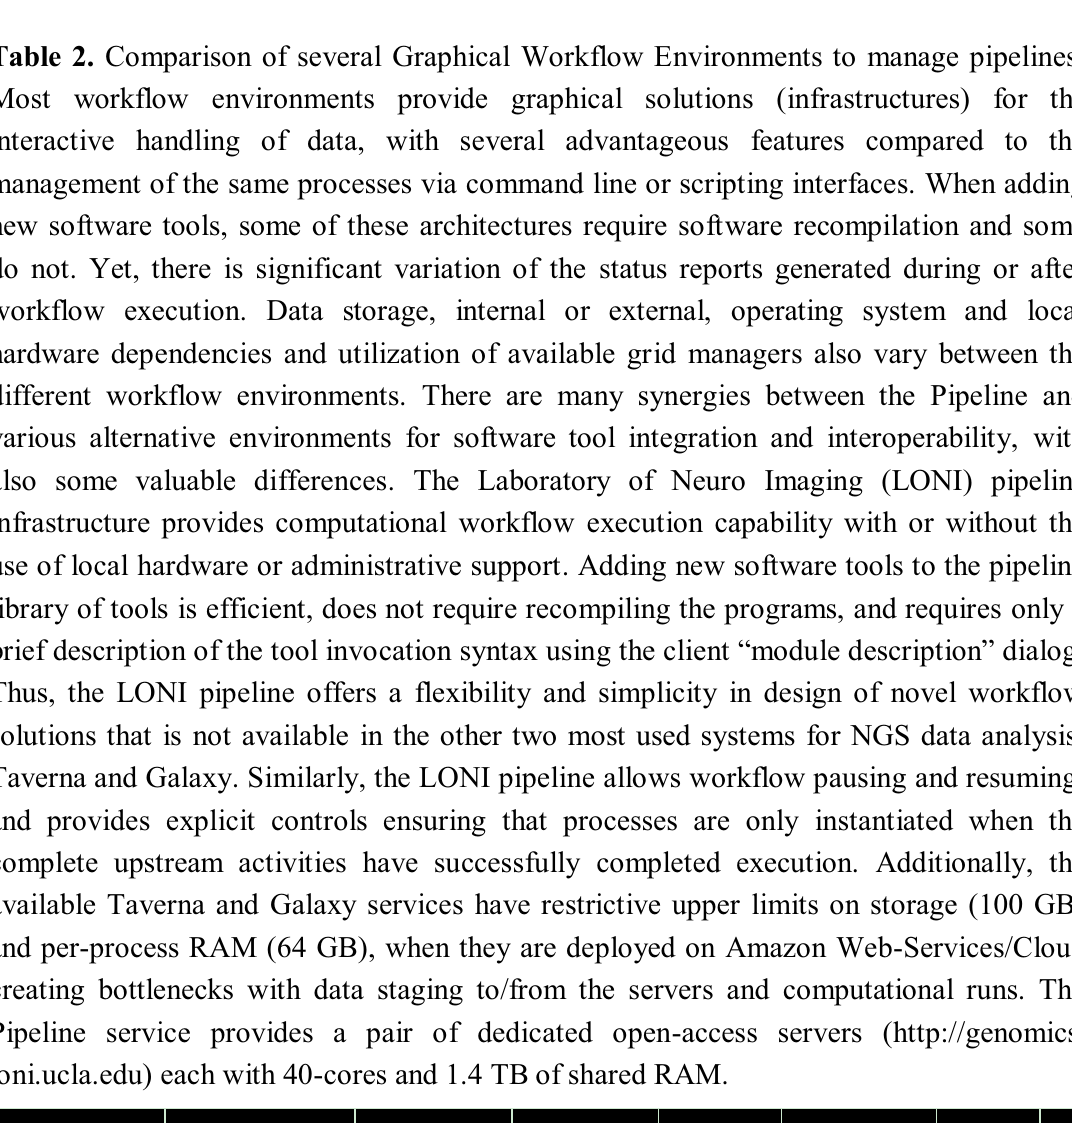
Table 2. Comparison of several Graphical Workflow Environments to manage